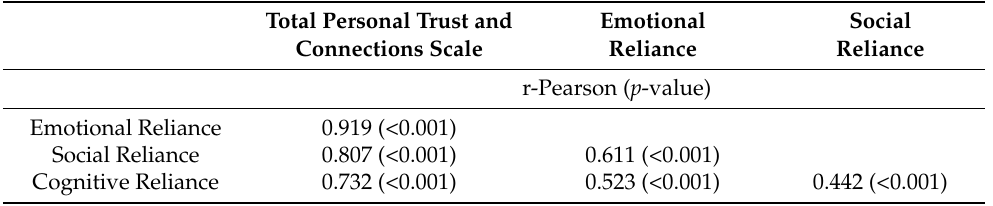
Table 4. Correlations between components and ‘Scale of Personal Trust and connections, PerTC’ scores of 218 participants in the current study.